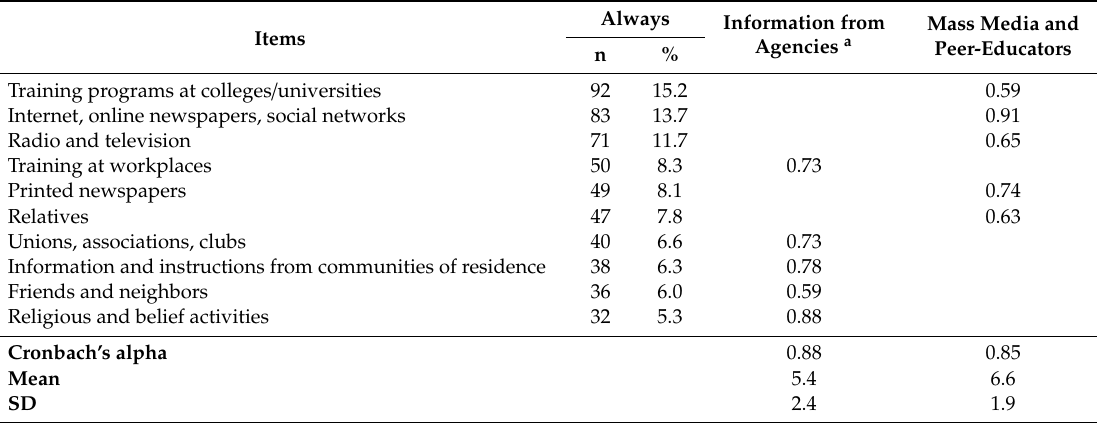
Table 2. Channels of accessing information regarding prevention and control of COVID-19. Items